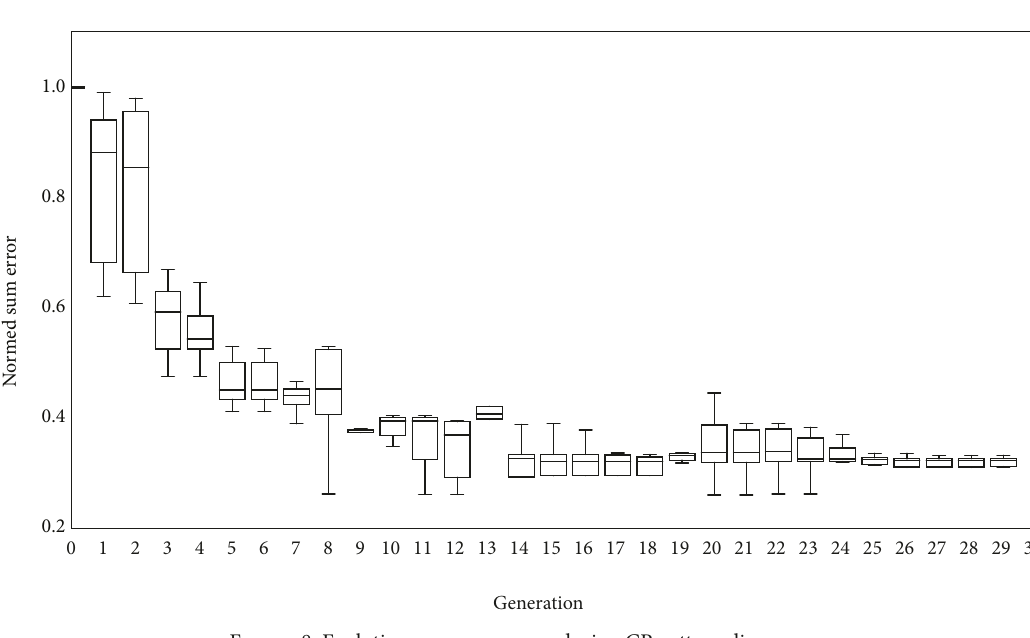
Figure 8: Evolutionary convergence during CP pattern discovery.